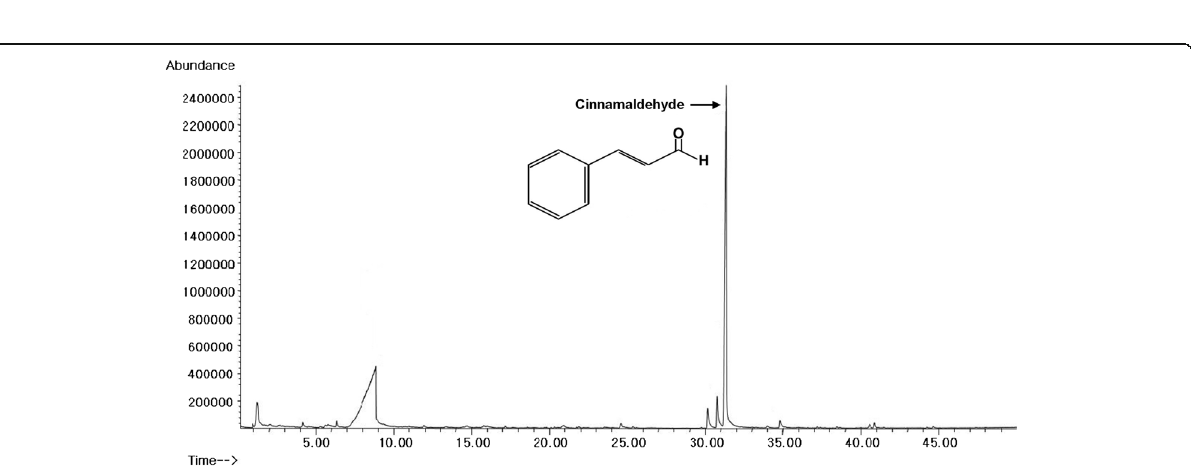
Fig. 7 The chromatography of GC/MS analysis of